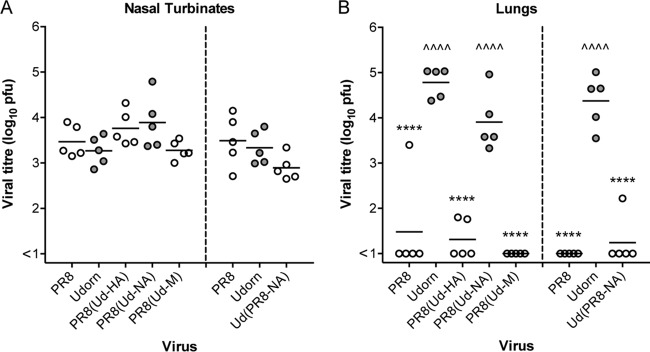
Viral titers in nasal turbinates and lungs of mice infected with reverse-engineered viruses via the URT route. BALB/c mice were infected with 104.5 PFU of hybrid viruses on either a PR8 (left) or Udorn (right) virus backbone, together with reverse-engineered PR8 and Udorn virus as controls. After 6 days, nasal turbinates (A) and lungs (B) were removed, and viral titers in homogenates were determined by plaque assay on MDCK cell monolayers. Individual titers (circles) and the mean viral titers of 5 mice per group (horizontal lines) are shown, expressed as titers per organ. Filled circles, viruses containing Udorn NA; open circles, viruses containing PR8 NA. Compared to PR8, ^^^^, P < 0.0001. Compared to Udorn, ****, P < 0.0001.